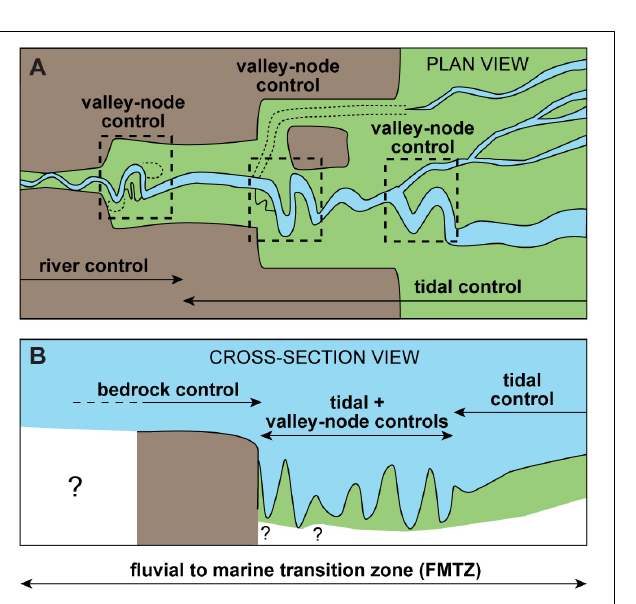
FIGURE 8 | Simplified model of the DNRS in plan view (A) and cross-section view (B) highlighting the river-tidal and valley-related controls.